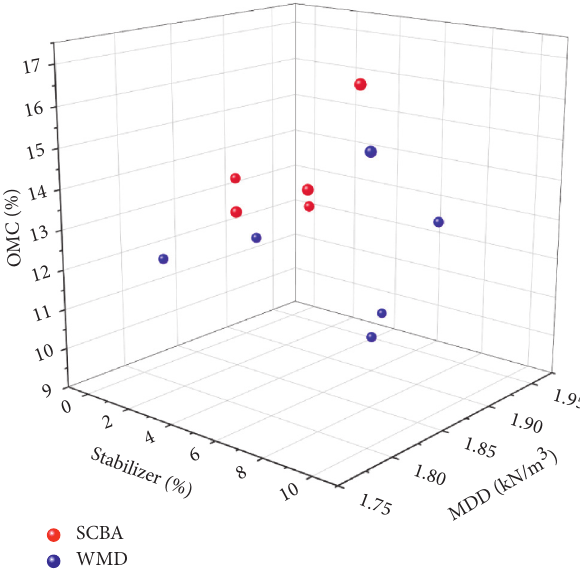
Figure 8: Variation of compaction characteristics (MDD and OMC) by incorporating SCBA and